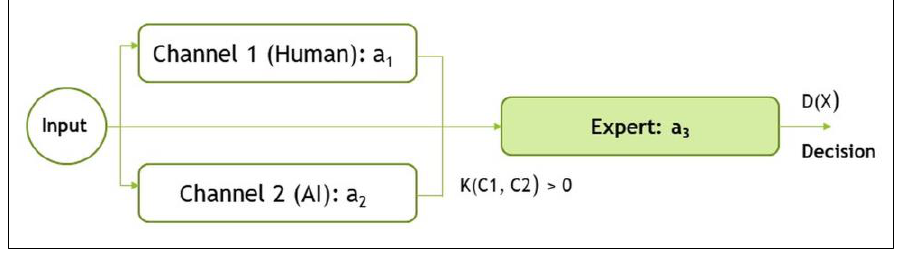
Figure 3. A multi-channel parallel system with an expert